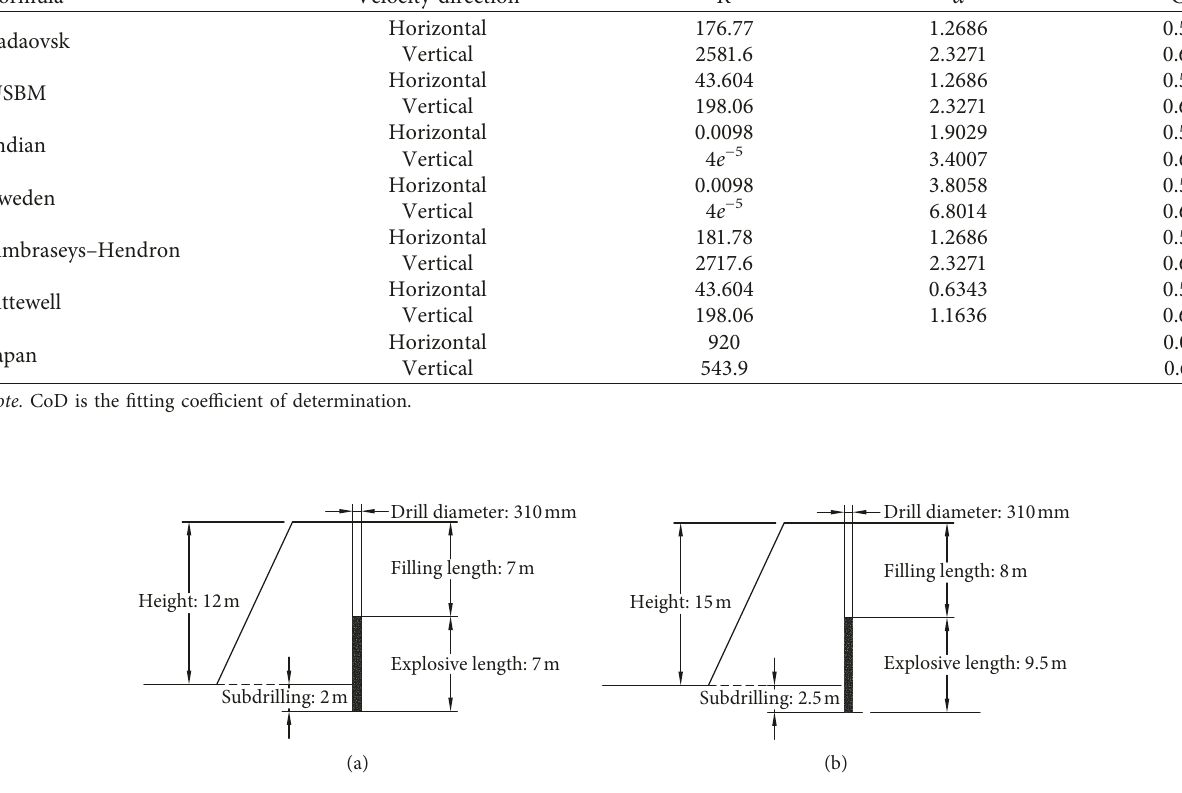
Figure 2: General blasting parameters for Sijiaying Iron Mine. Table 5: Prediction models with terrain